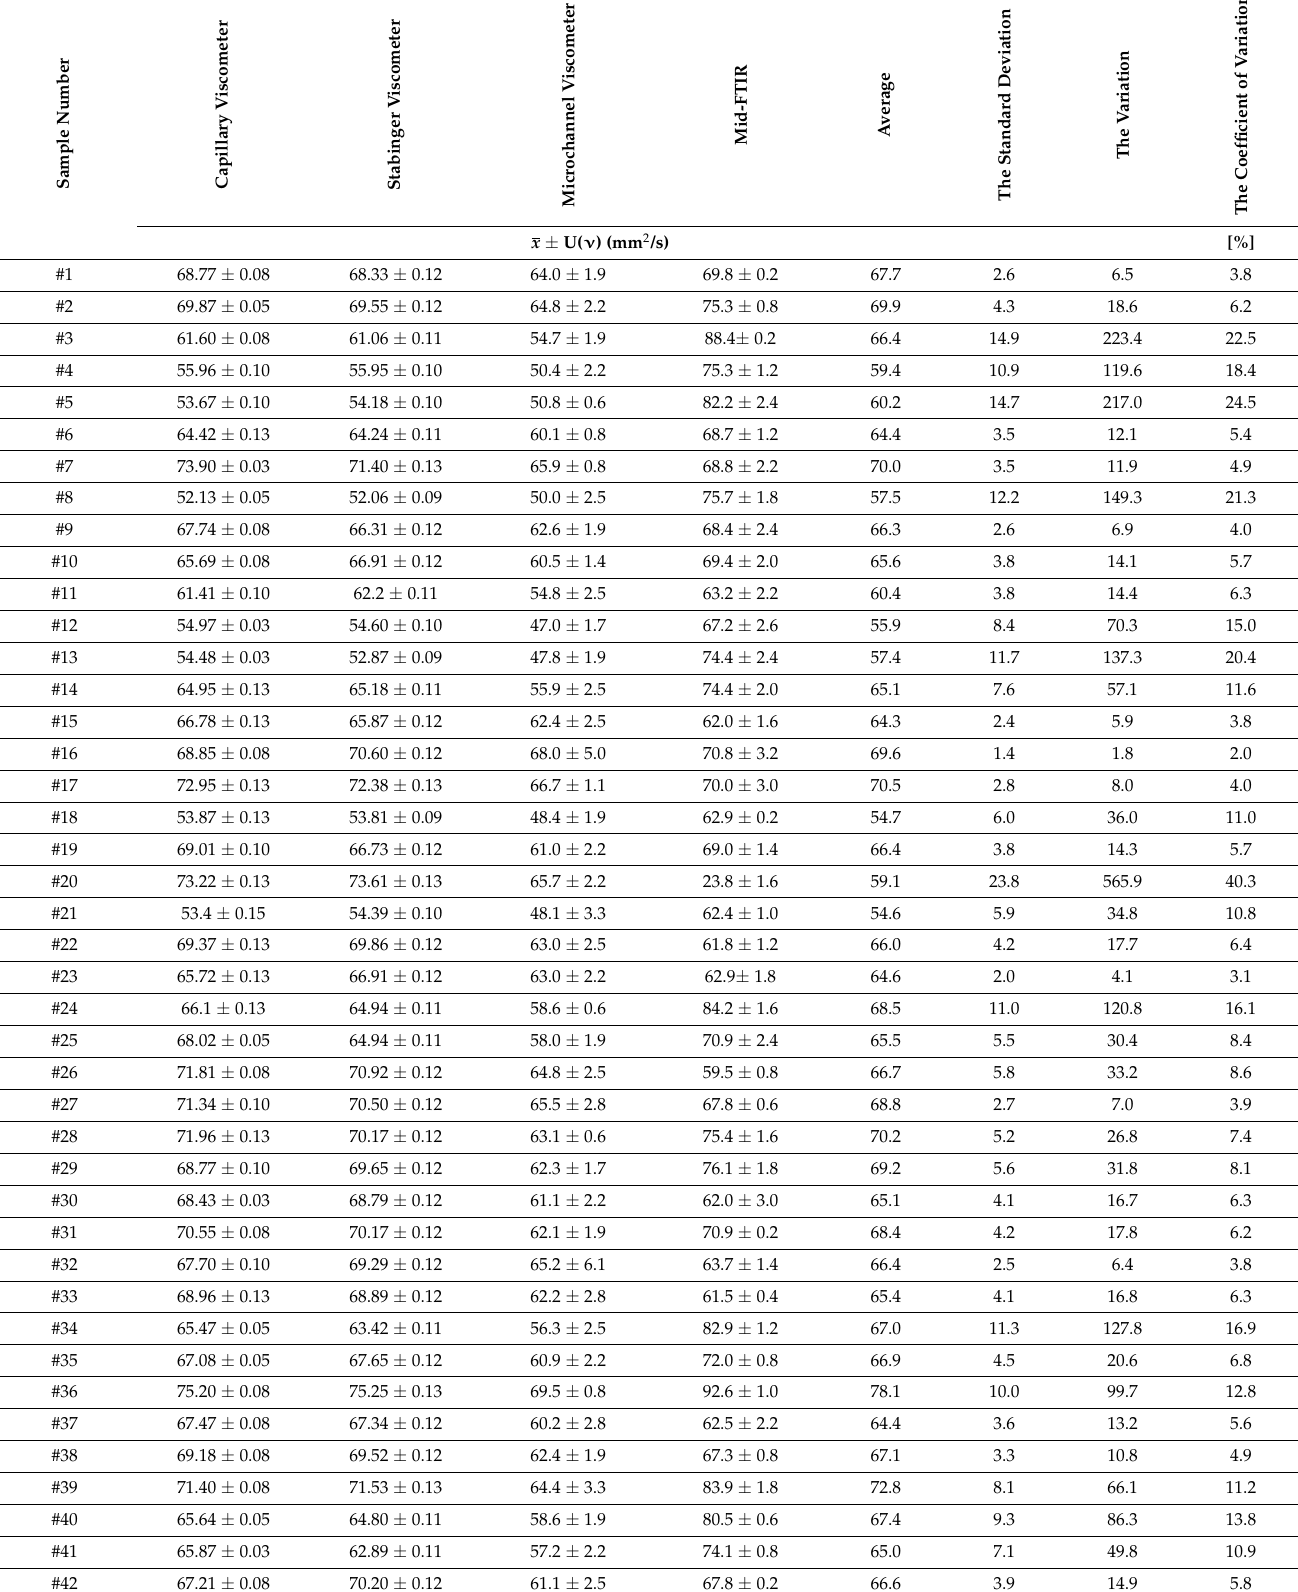
Table 3. Kinematic viscosity measured at 40 ◦ C with the use of four different devices, and the basic descriptive